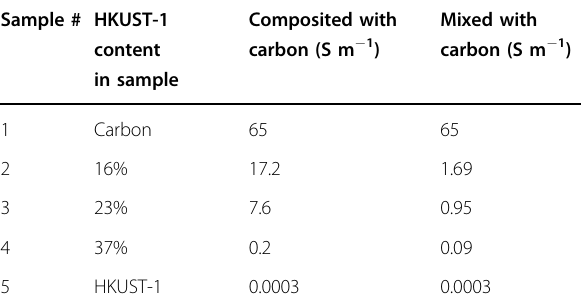
Table 1 Lateral electrical conductivities of HKUST-1/ carbon composites with different MOF/carbon ratios, which indicate the signi fi cant advantages of our composition method compared to simple mixing of the MOFs with